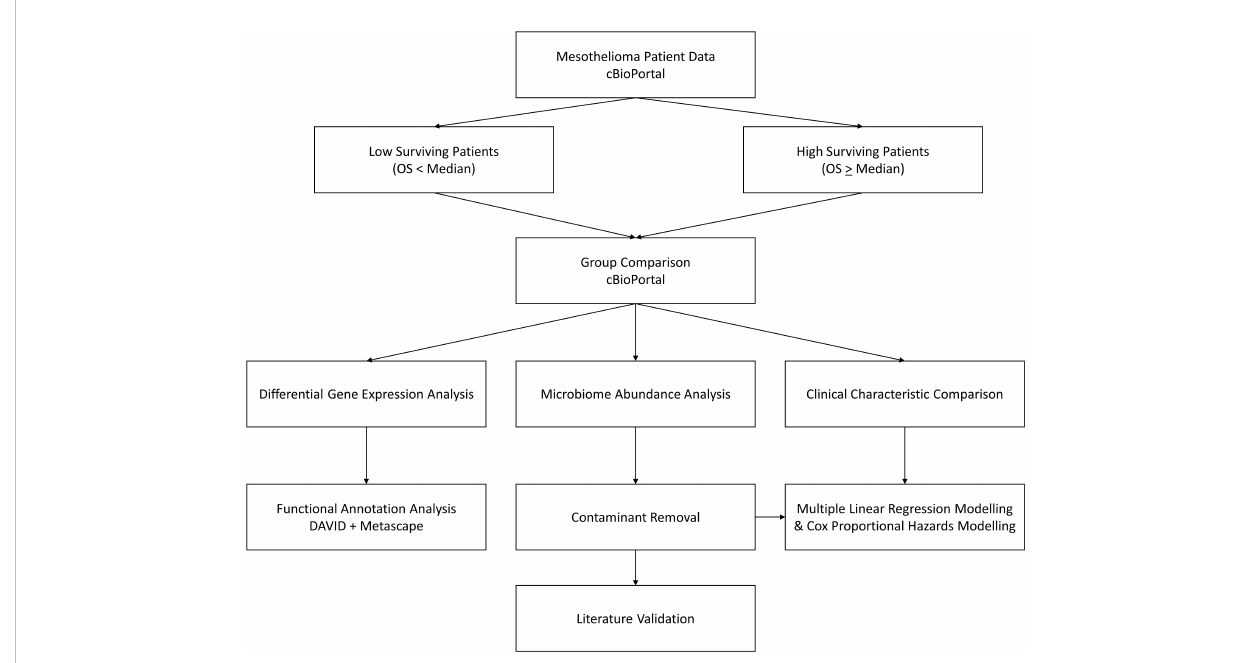
FIGURE 1 Work fl ow diagram. cBioPortal represents the starting point, where MMe patient data is accessed and patients are divided by the median overall survival. These two groups are then compared to assess differences in clinical characteristics, identify differentially expressed genes, and identify differential abundance in microbiome signatures, which is taken forward for contaminant removal, literature validation, and survival